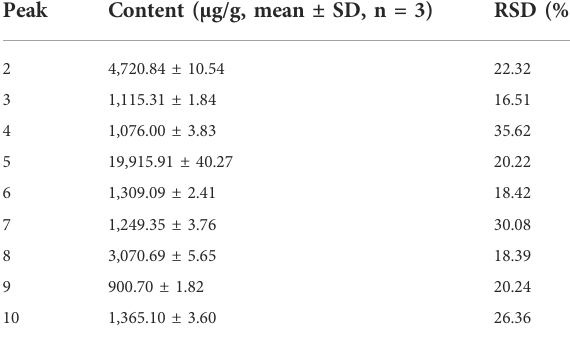
TABLE3Quantitativedeterminationofninemaincompoundsinthree batches of